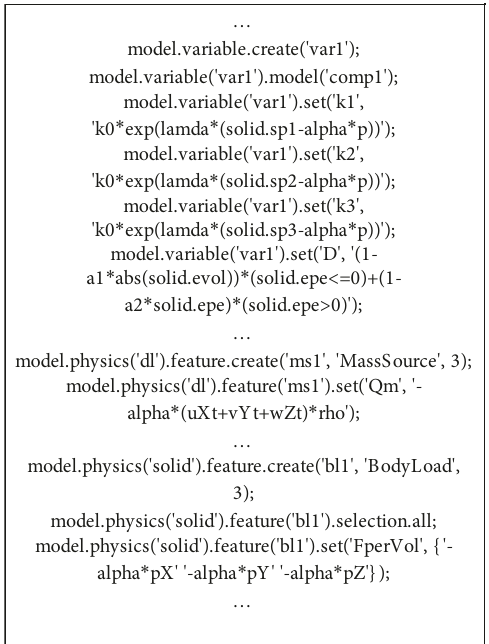
Figure 2: Partial program code of improved multiphysics coupling